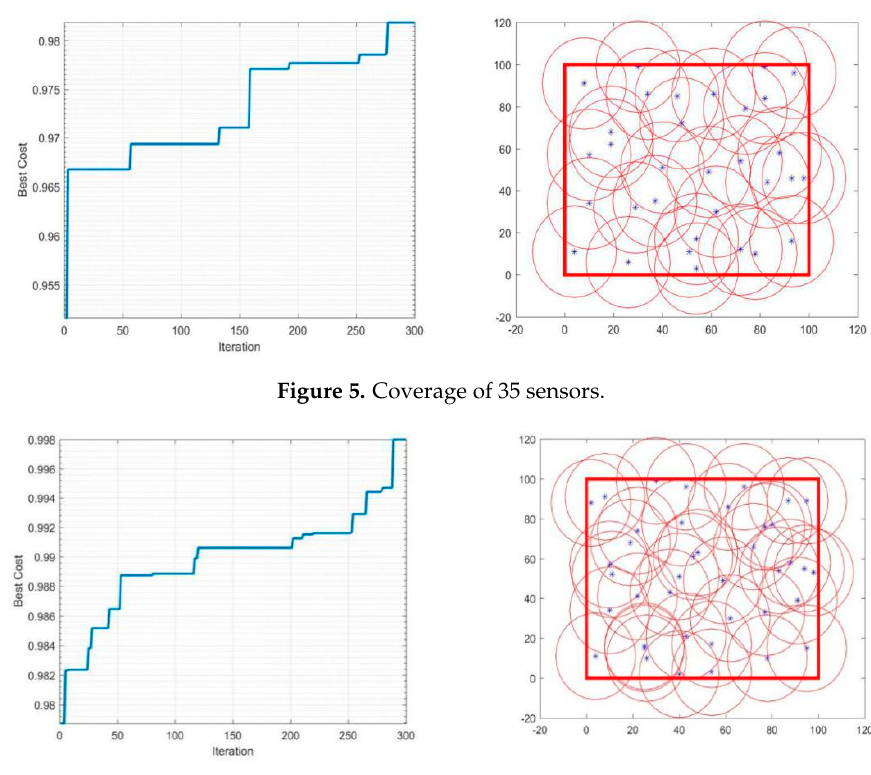
Figure 4. Coverage of 30 sensors.